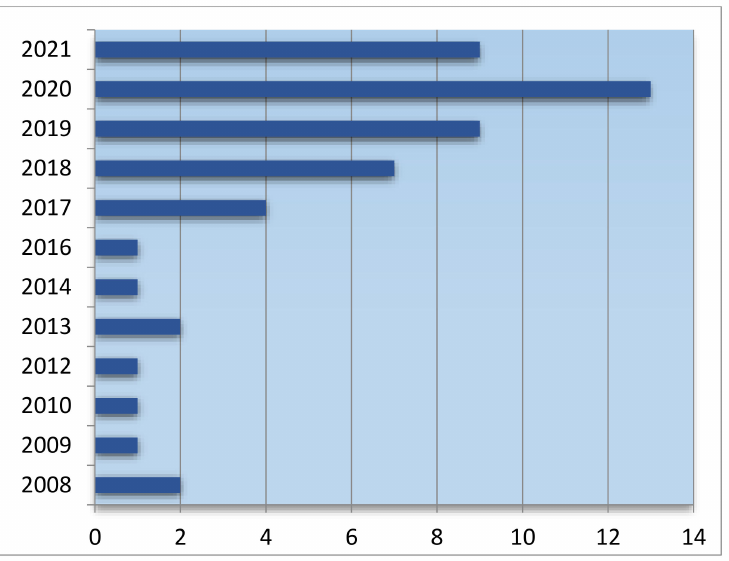
Figure 4. The number of publications per year after 2nd